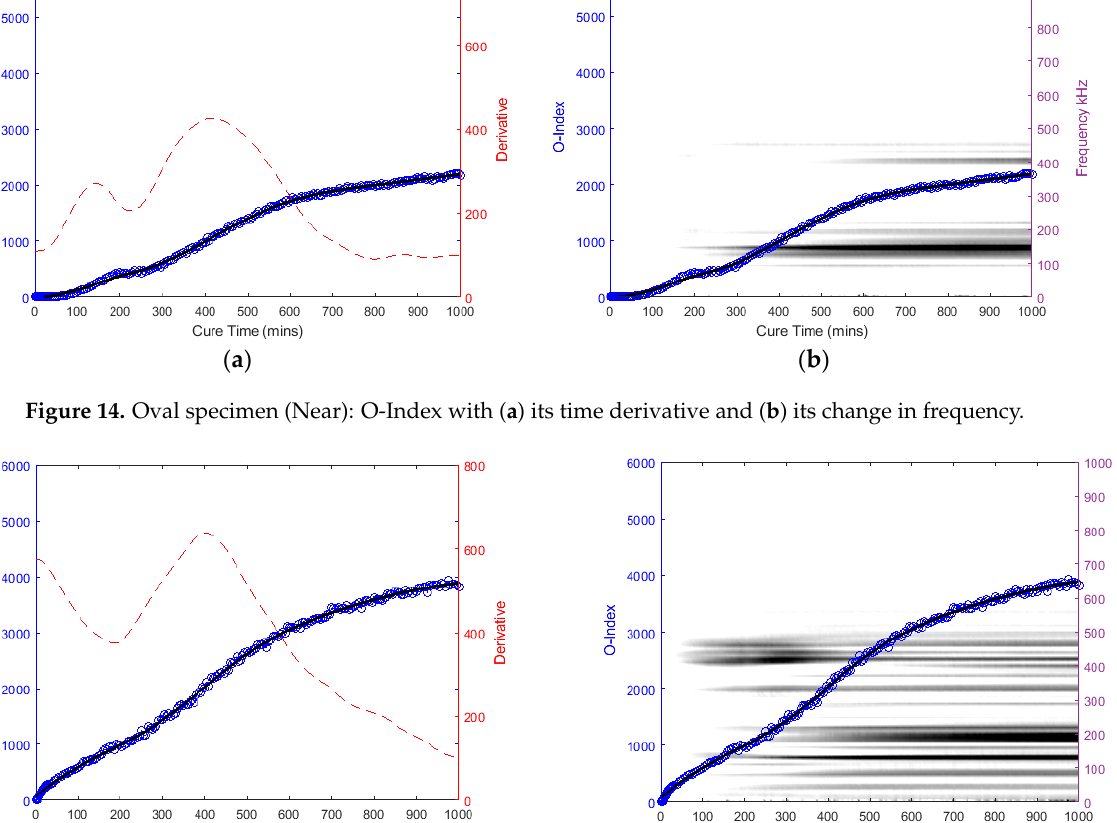
Figure 15. Oval specimen (Far): O-Index with ( a ) its time derivative and ( b ) its change in frequency.